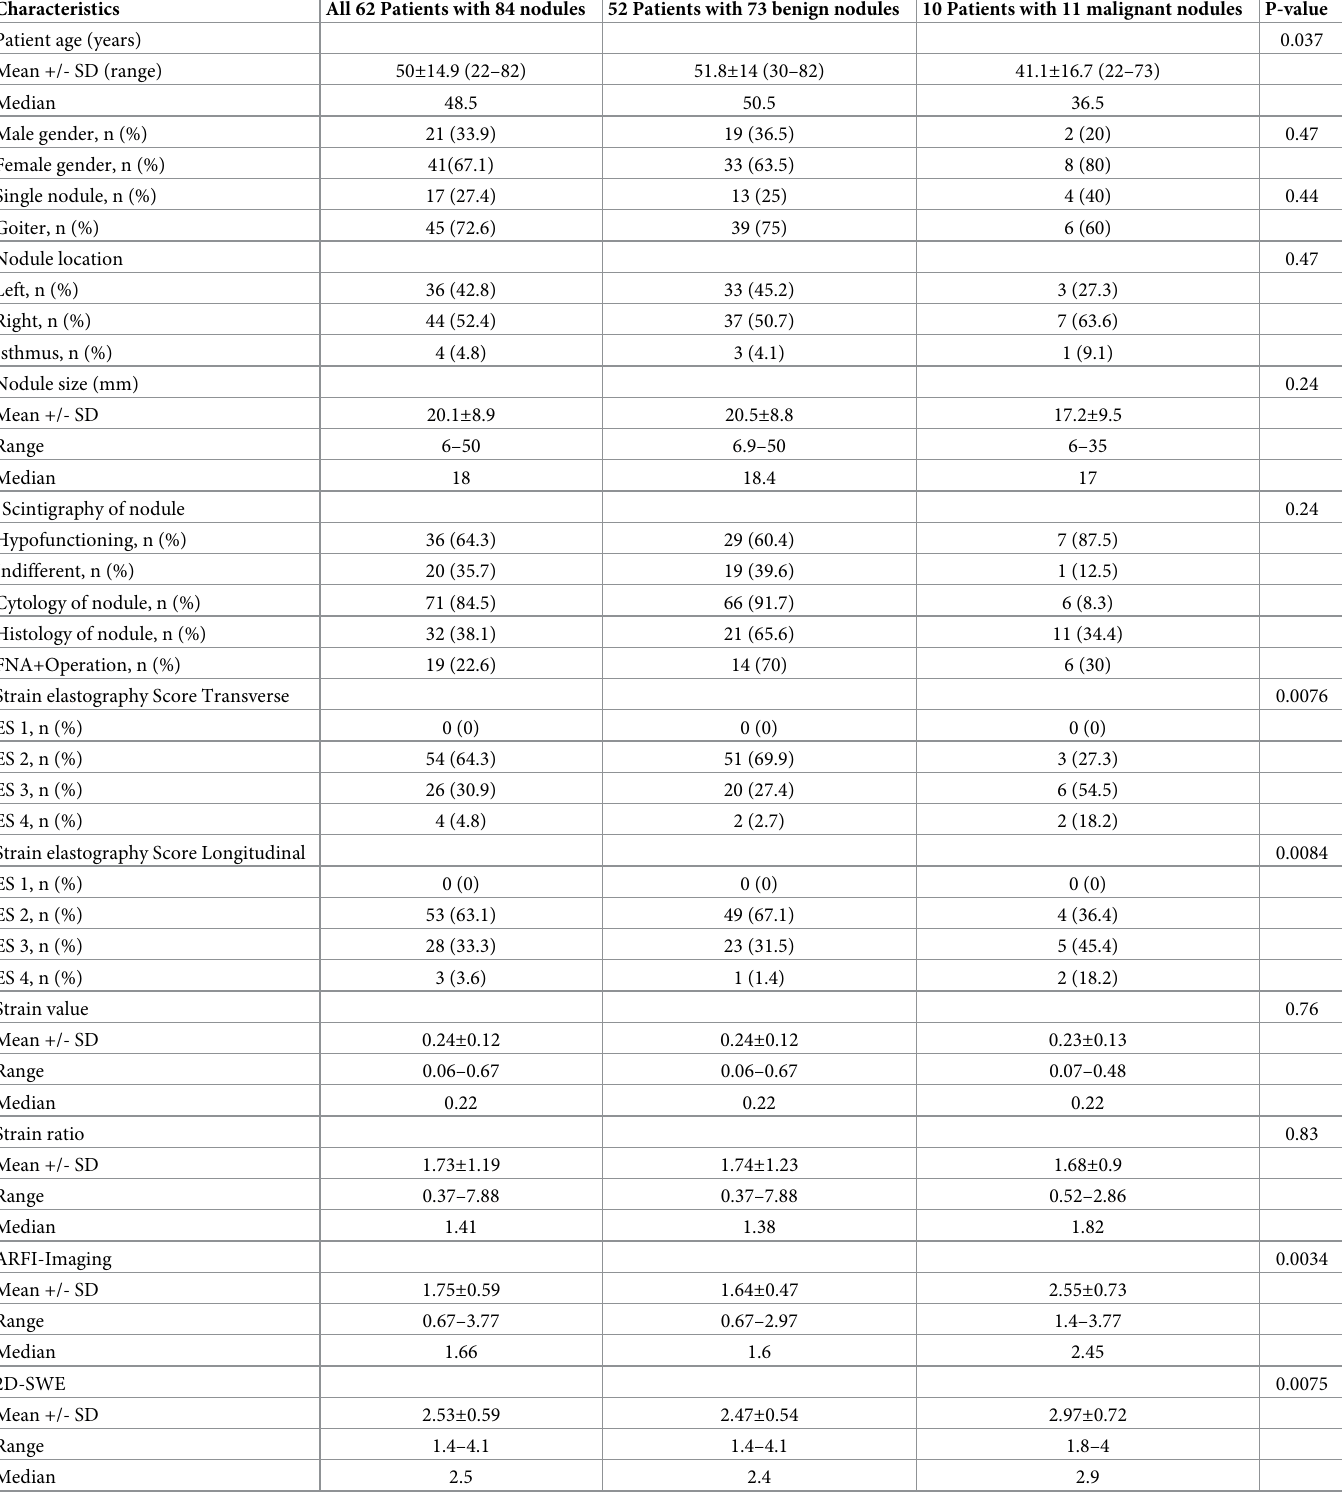
Table 1. Patient characteristics.